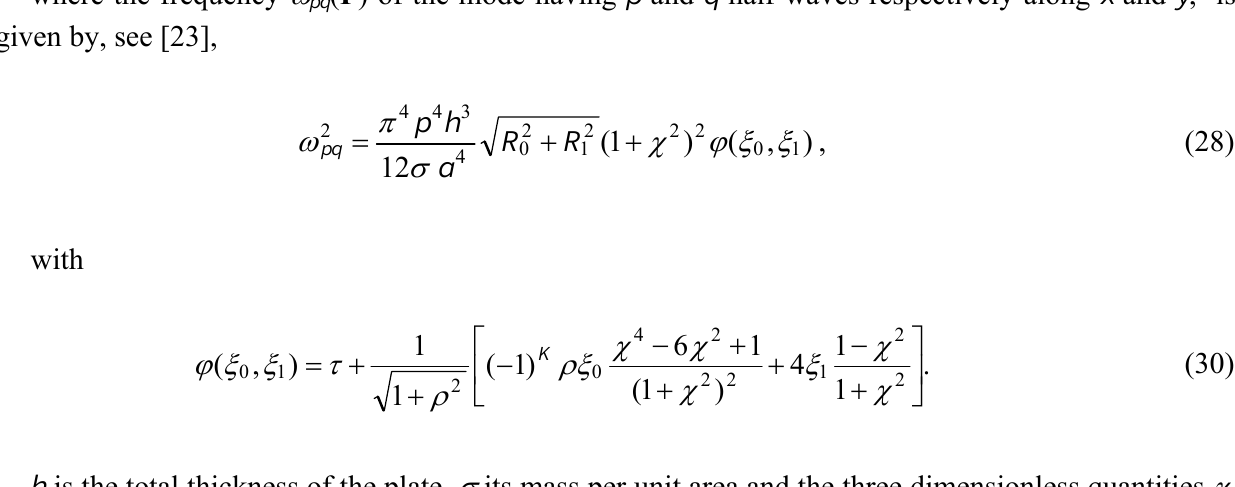
*, D * , almost superposed, and B xx xx